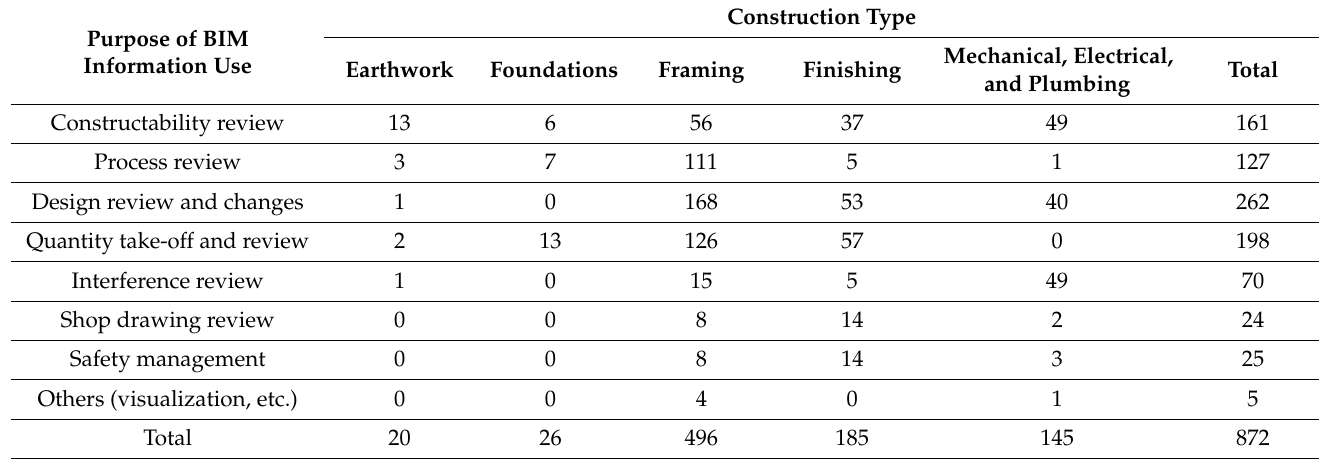
Table 1. Classification of construction types for BIM RFIs by purpose of information use.